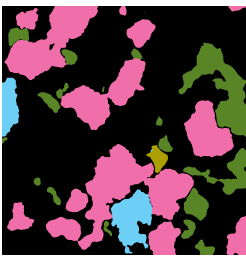
Figure 11. The model minimizing WCE does correctly classify encrusting Montipora . The same is true when minimizing FT, but only after a slight balancing of the rare classes using the Poisson-disk sampling. In this case, with respect to the model that is only minimizing WCE, the network is more accurate in predicting the contour pixels of